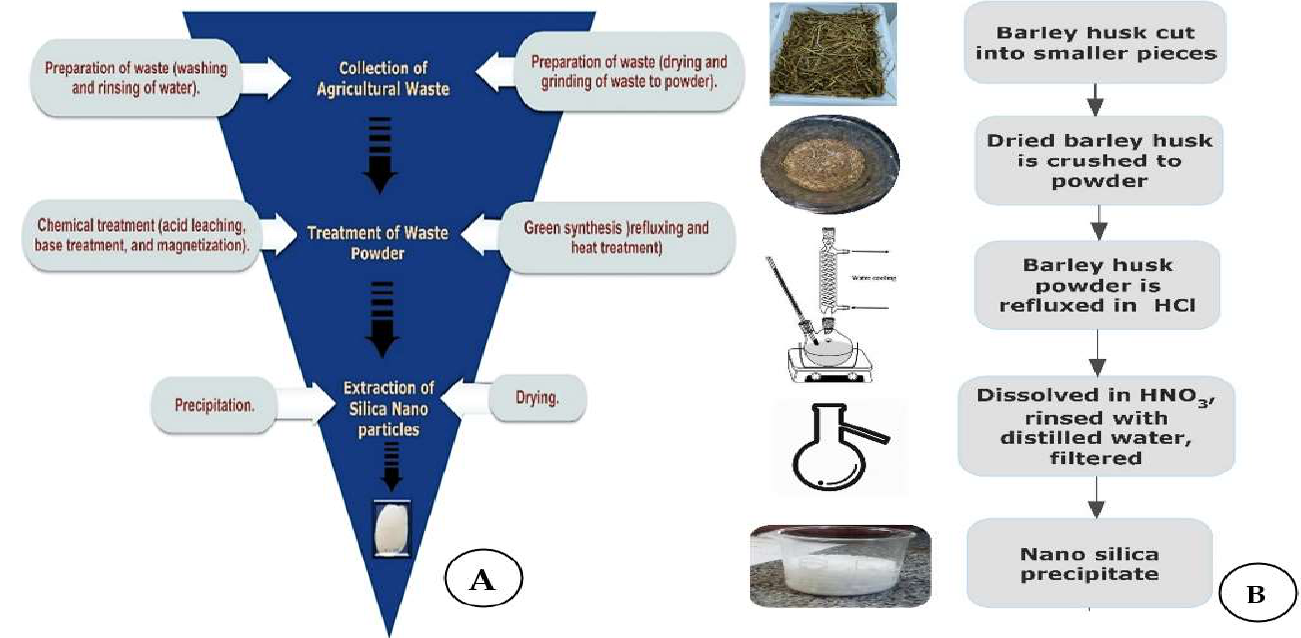
Figure 1. Schematic diagram of the experimental procedure ( A ): block diagram; and ( B ) process used. Adapted, in part, with permission from Ref. [30]. 2020, Akhayere et al.